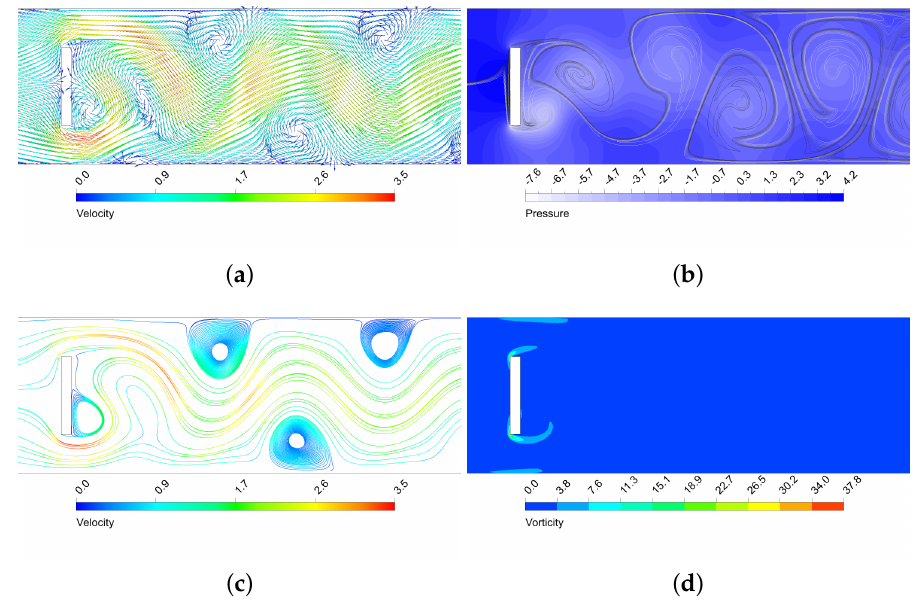
Figure 10. Performance of the maxEf f micro heat exchanger near the rectangular structure. ( a ) Dimensionless velocity vector field; ( b ) Dimensionless static pressure (with mixing structures on top); ( c ) Streamlines (dimensionless velocity coloured scale); ( d ) Dimensionless vorticity.